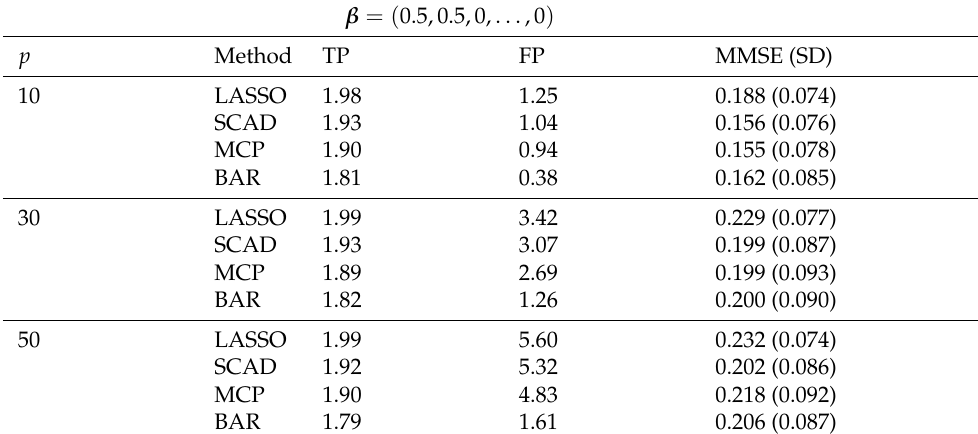
Table 5. Simulation results based on the joint selection of the tuning parameter and bandwidth n = 100 for existing noncontinuous covariate.